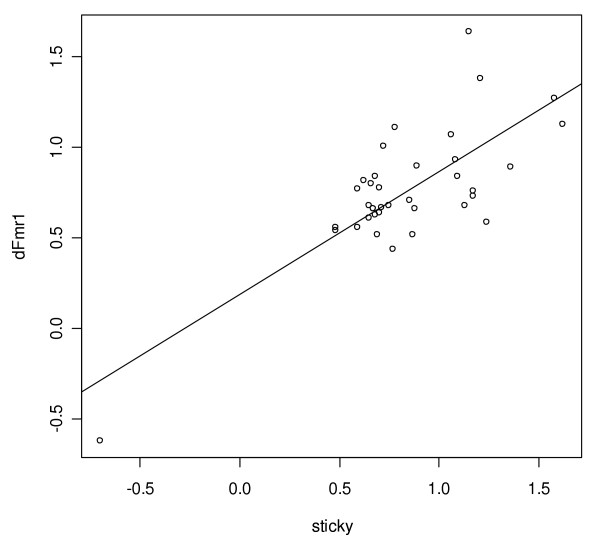
Commonly misexpressed genes tend to be overexpressed. Plot of microarray log fold changes observed in sticky versus dFmr1 for the 40 genes found to be differentially expressed in both mutants. R2 = .581 and a two-tailed P value is < 0.0001 for 39 degrees of freedom.